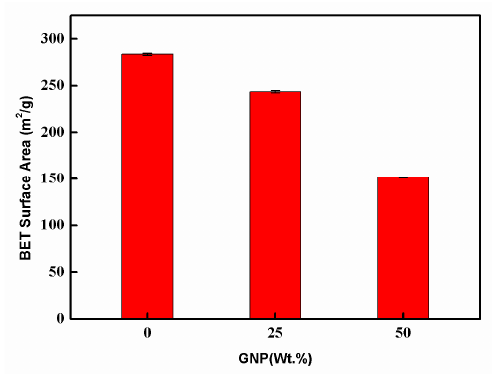
Figure 7. Surface area of the hybrid film varied with the GNP weight percentages.